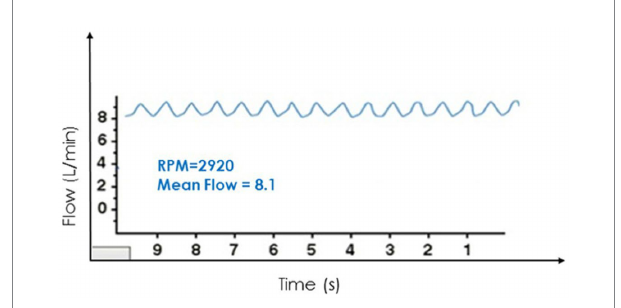
FIGURE 2 Representative heartware tracings of severe aortic insufficiency. Reproduced with permission from